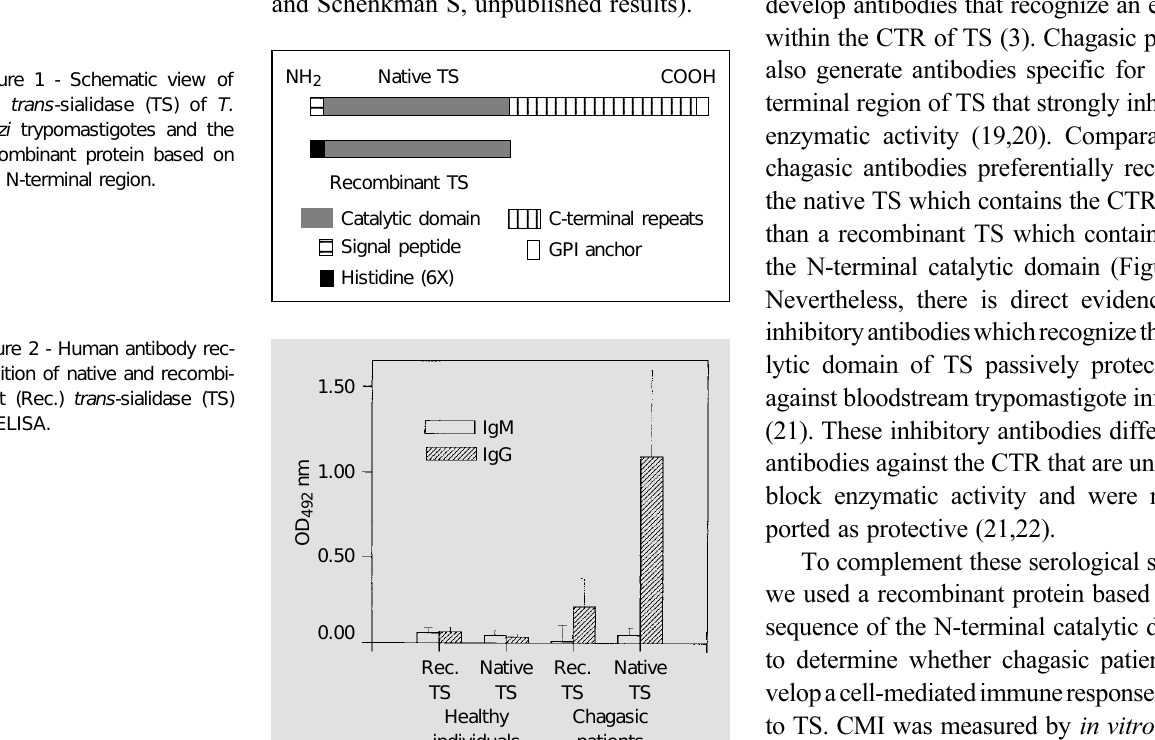
2 - Human antibody rec- ognition of native and recombi- nant (Rec.) trans -sialidase (TS) by